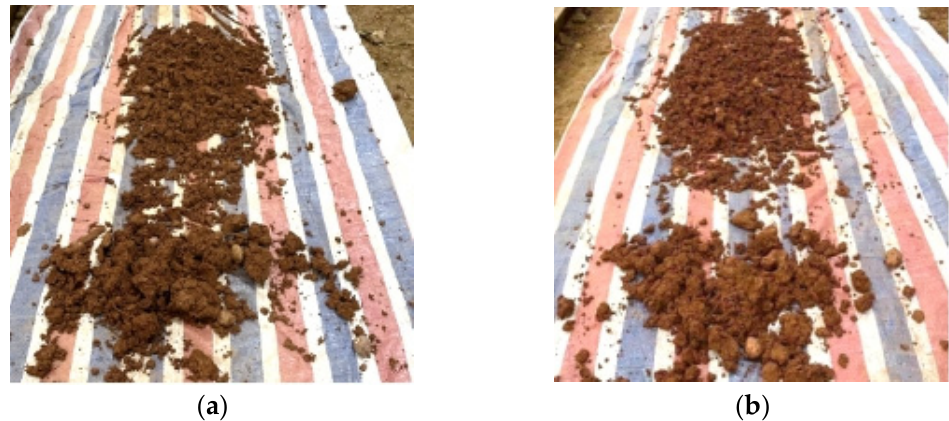
Figure 10. The separation effect in different scenarios. ( a ) Without soil-crushing mechanism; ( b ) with soil-crushing mechanism.